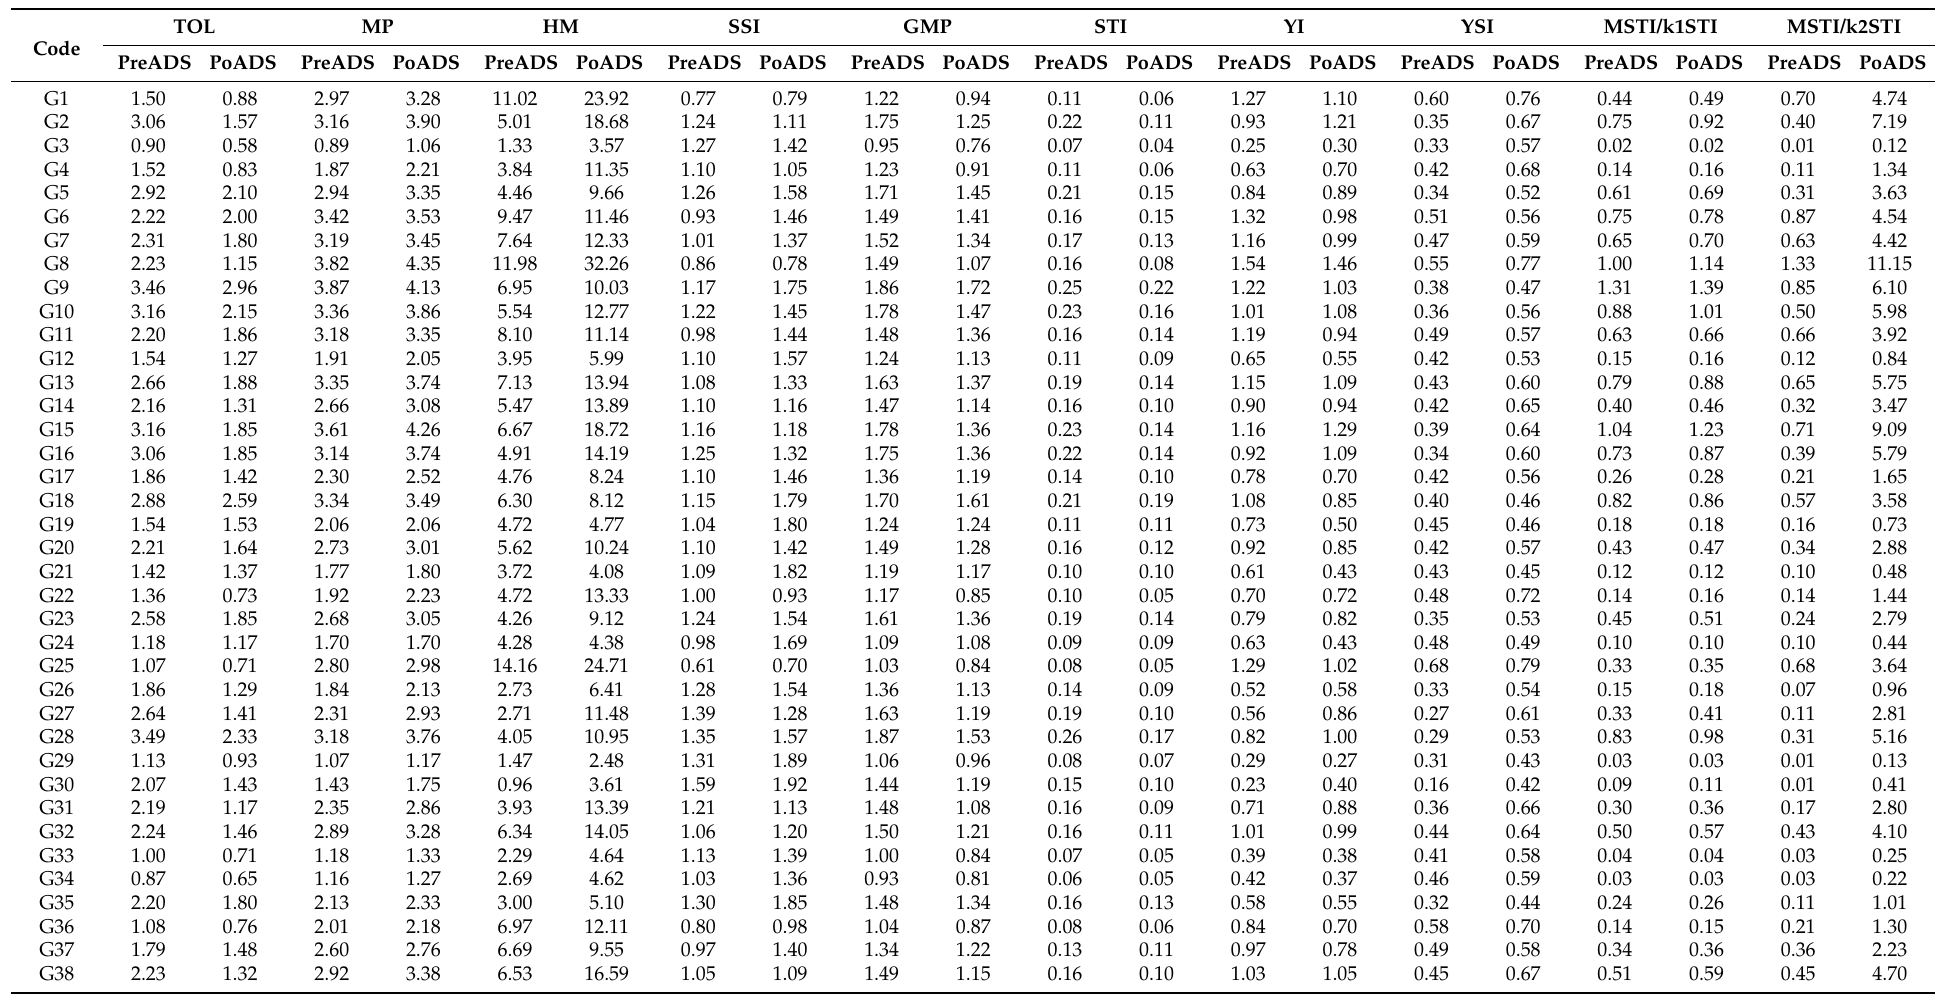
Table 3. Values of tolerance, susceptibility indices, and grain yield of the assessed sorghum genotype under stress and non-stress conditions in glasshouse and field